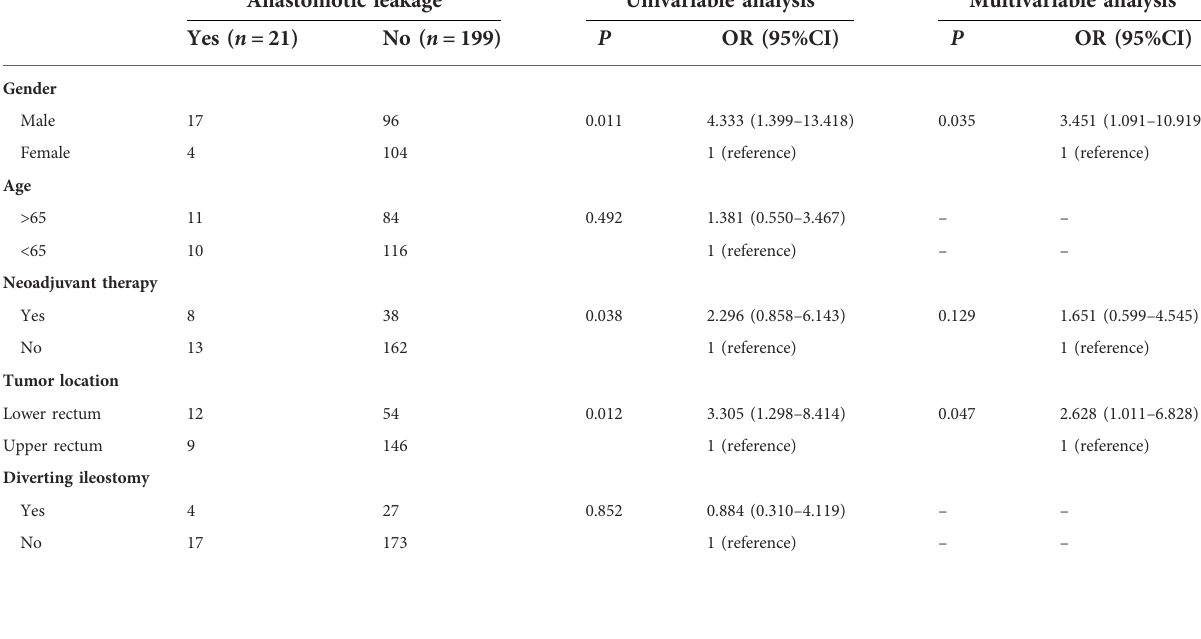
TABLE 3 Risk factors for anastomotic